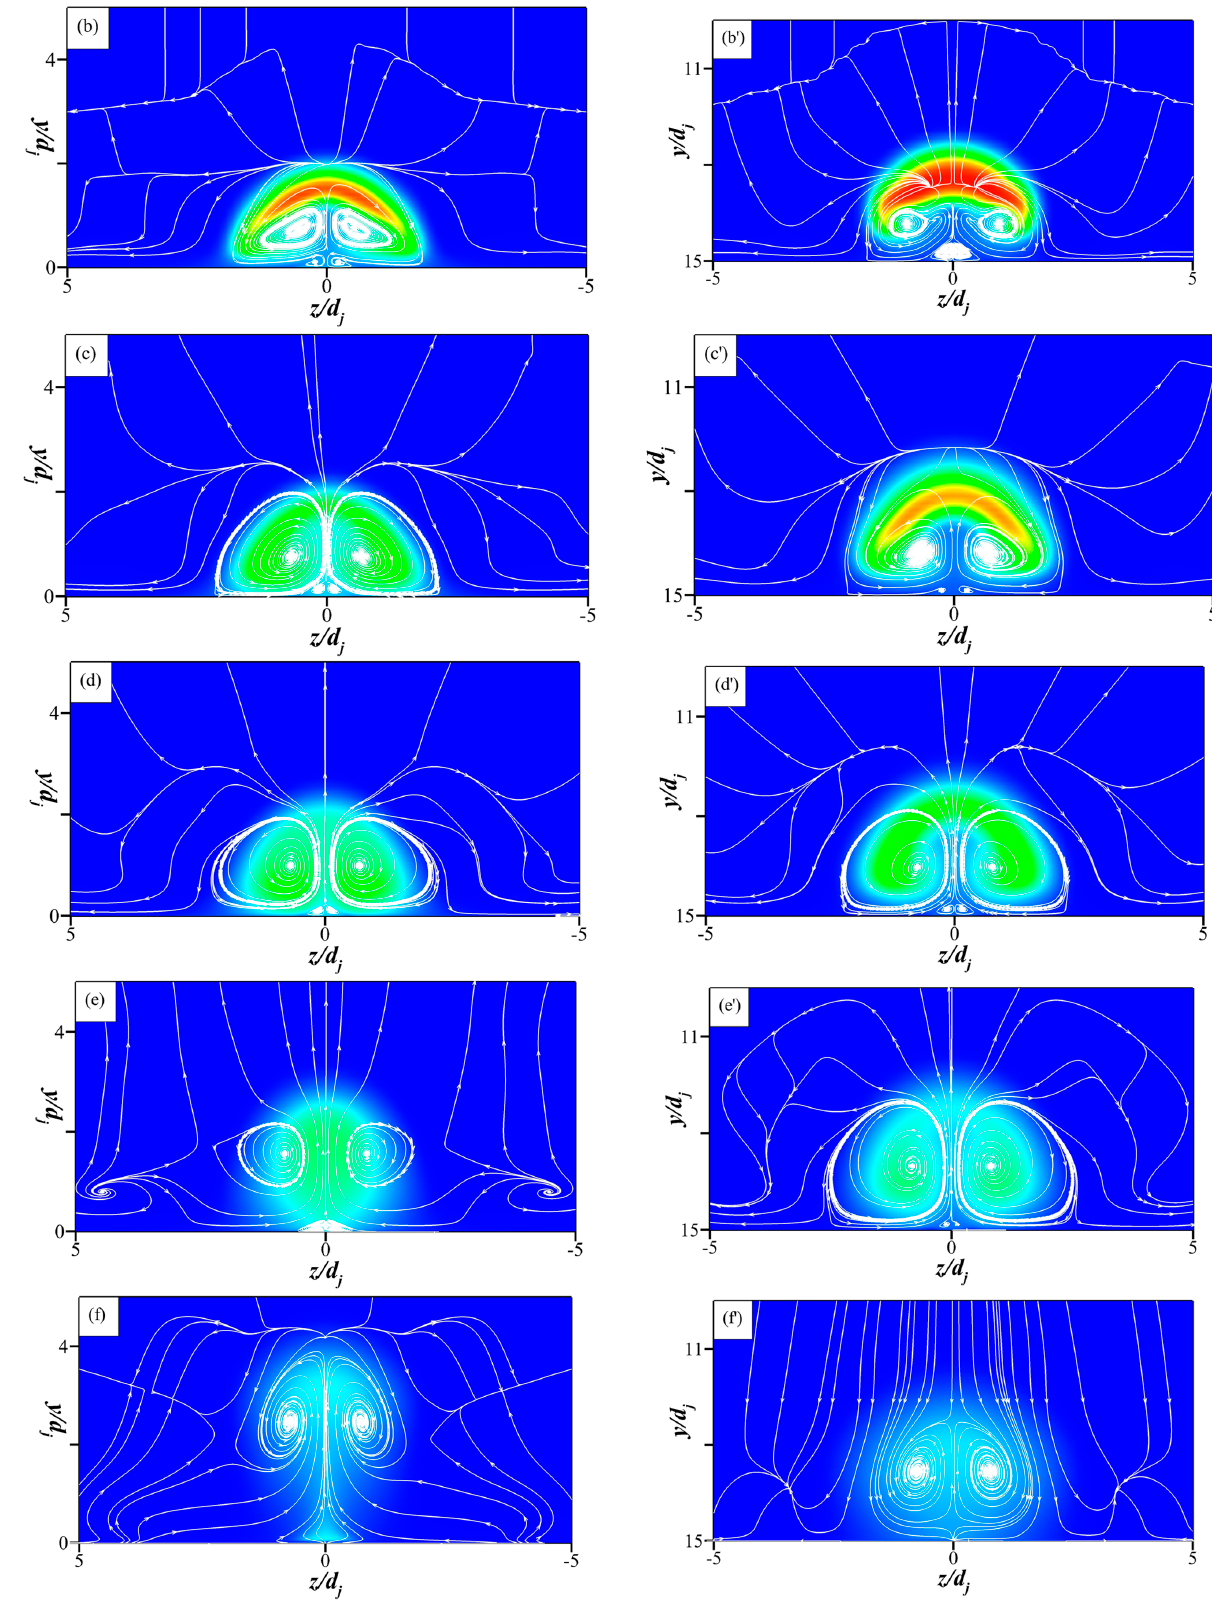
Figure 11. Mass fraction and streamline distribution of hydrogen at x / dj = 0, 2, 4, 6, 10, and 20 in Case 3 ( left : lower wall, right : upper wall).